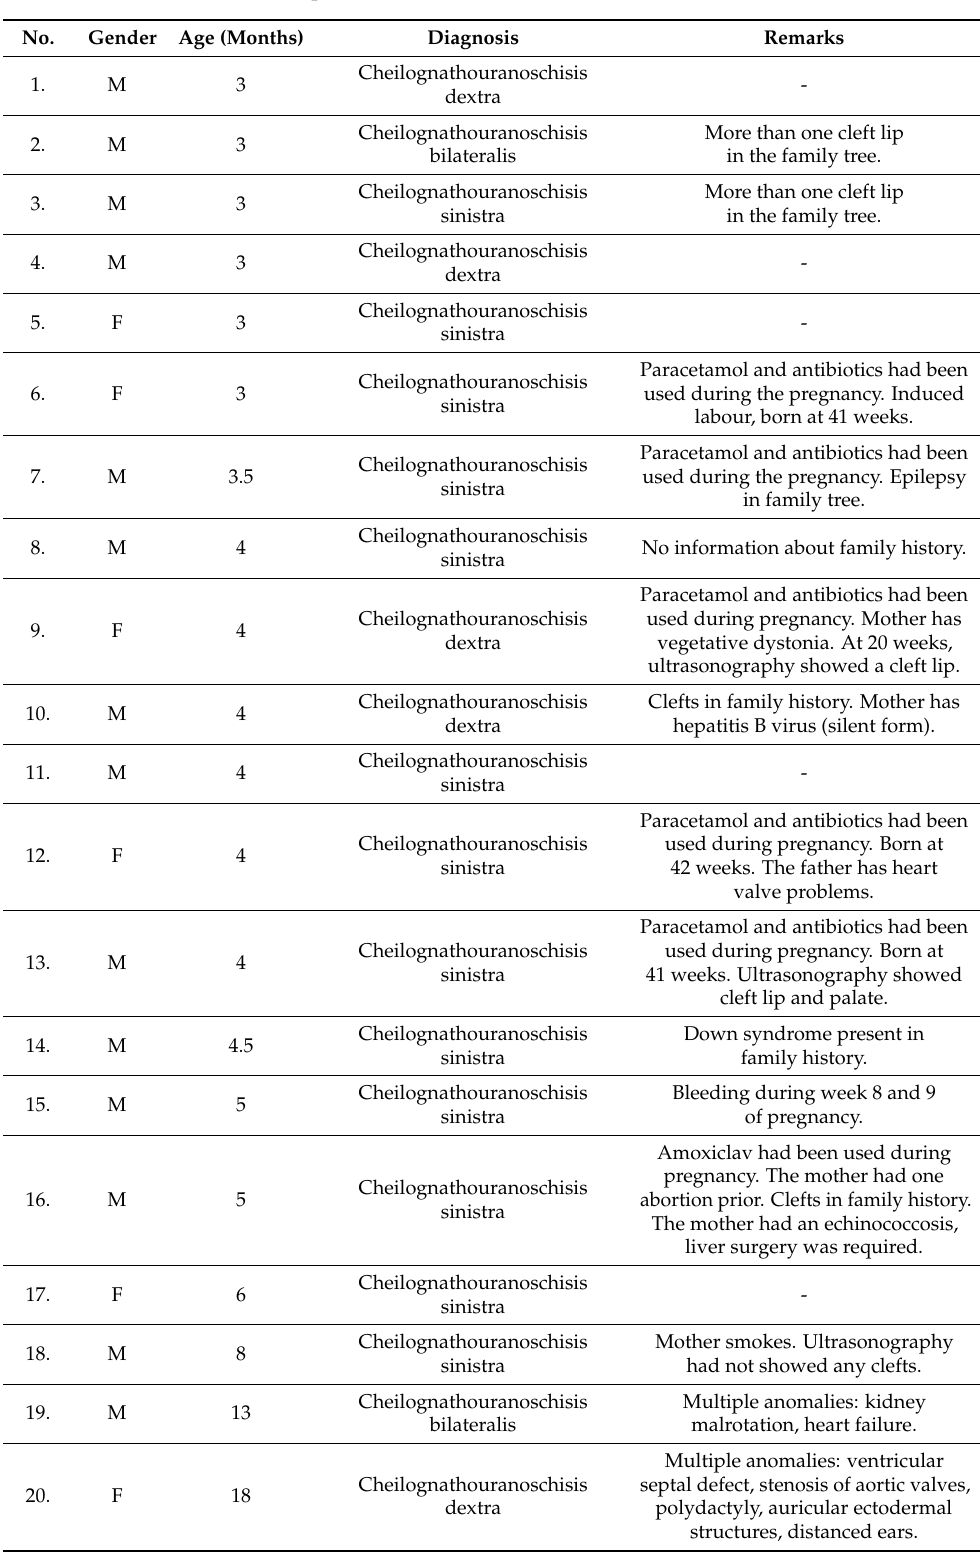
Table 1. Information about the